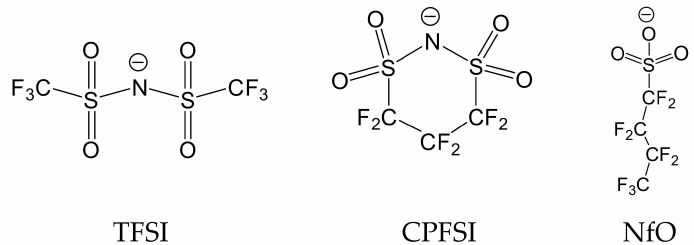
Figure 1. Chemical structures of TFSI, CPFSI, and NfO